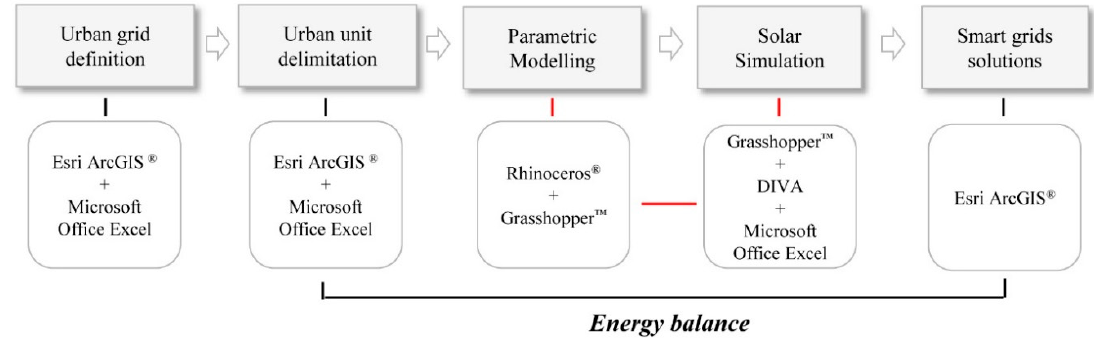
Figure 2. Interactive workflow.